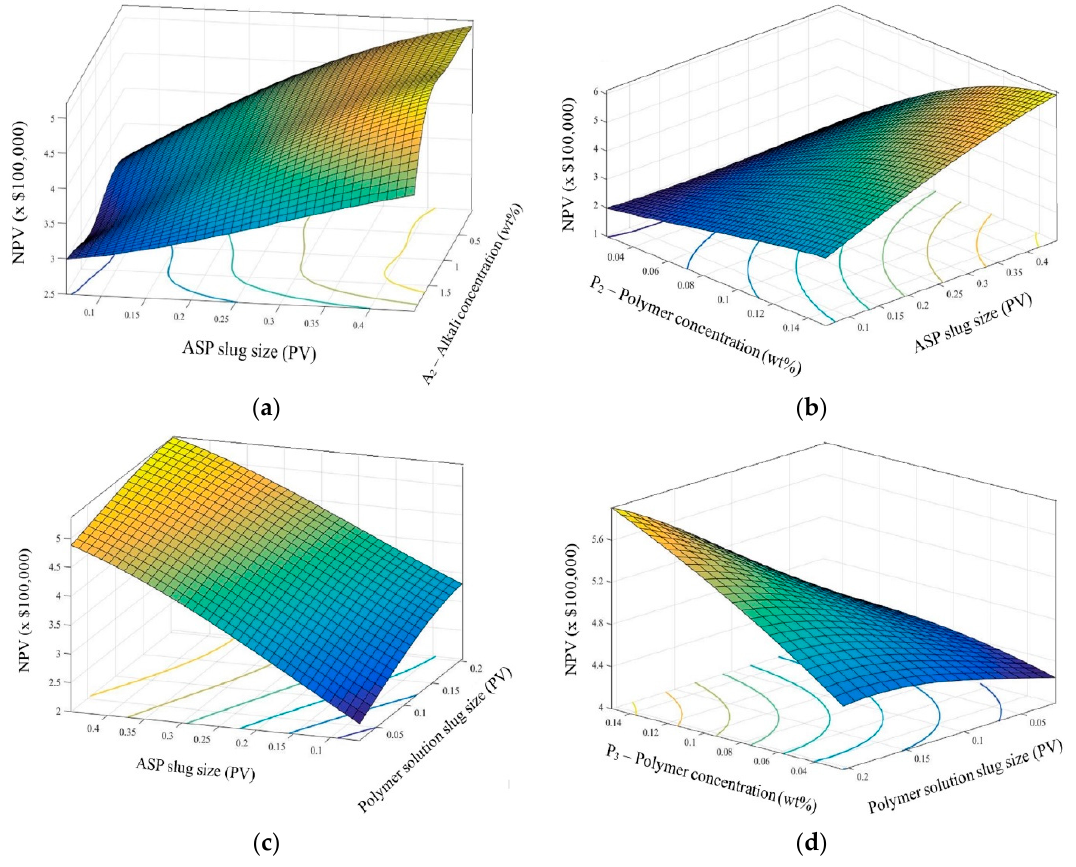
Figure 9. Interaction of high-impact parameters on NPV value (at 45 $/bbl): ( a ) ASP_size and A2; ( b ) ASP_size and P2; ( c ) ASP_size and P3_size; ( d ) P3 and P3_size. The increase of ASP slug size enhances NPV with a higher magnitude than other parameters.